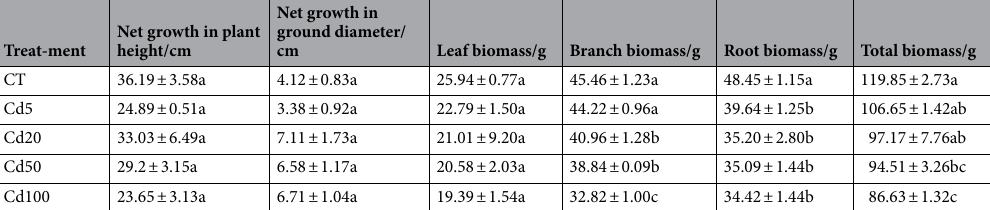
Table 1. The growth characteristics of sassafras seedlings under different levels of cadmium treatment. Different lowercase letters in the same column indicate significant differences between different cadmium concentration treatments ( P < 0.05).